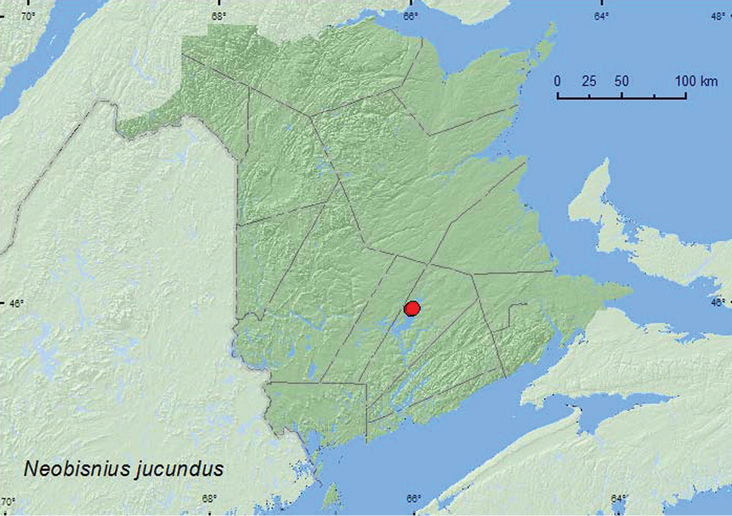
Collection localities in New Brunswick, Canada of Neobisnius jucundus.